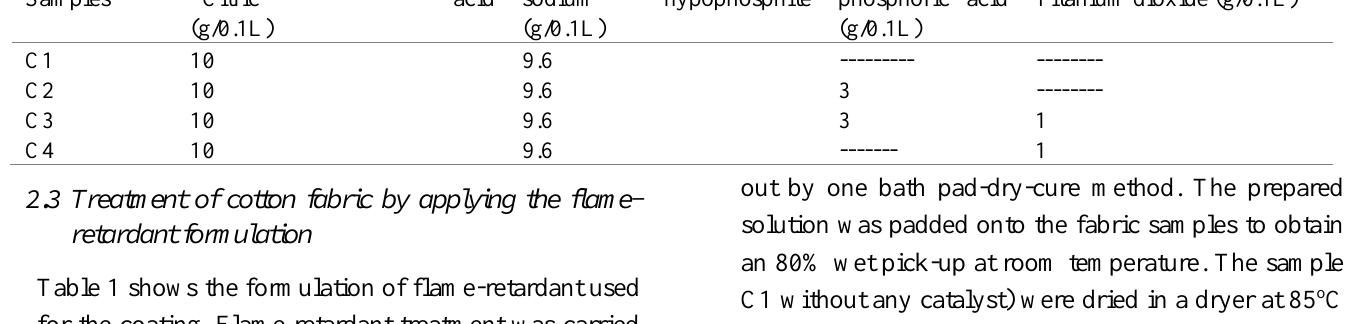
Recipe formulation Samples